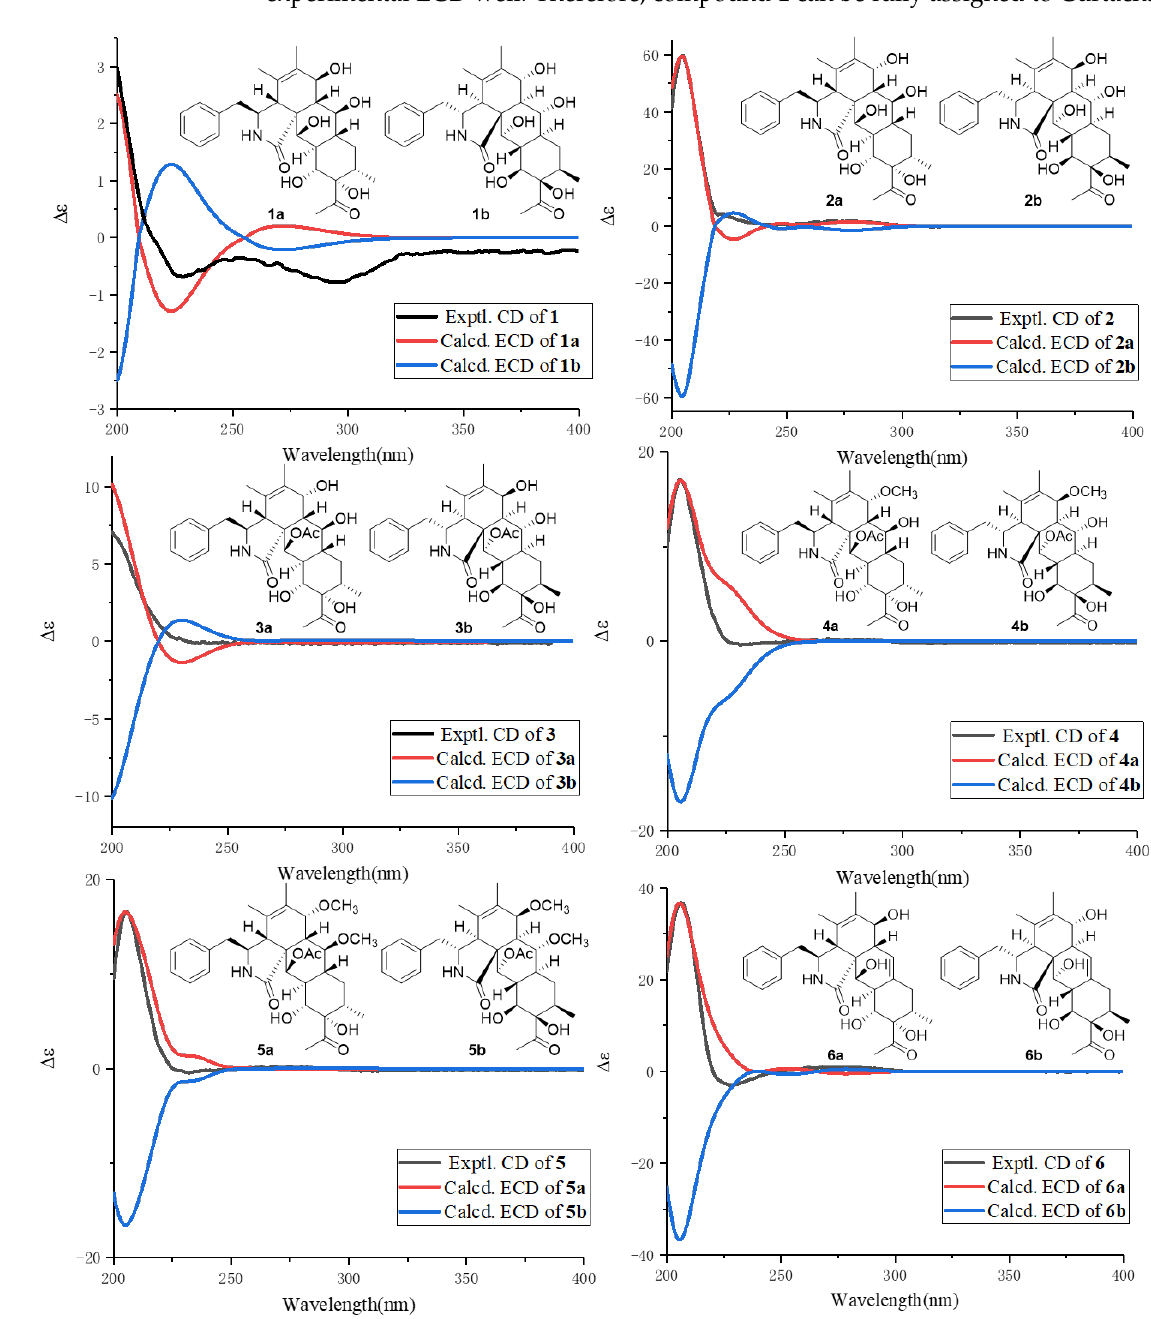
Figure 3. Experimental and calculated ECD curves of compounds 1 – 6 . Compound 2 was obtained as a colorless powder and had the same molecular formula (C 28 H 37 NO 7 ) as compound 1 , according to HRESIMS. Their NMR (Tables 1 and 2) signals were almost identical, except that the coupling constant of H-7/H-8 (3.0 Hz) in 2 was smaller than the coupling constant of H-7/H-8 (10.0 Hz) in 1, which indicated 2 as an epimer of 1 . In addition, from 2D NMR correlations (Figure 4), the NOE correlations of 7-OH/H-13, and H-7/H-8, coupled with the coupling constant of H-7/H-8 (3.0